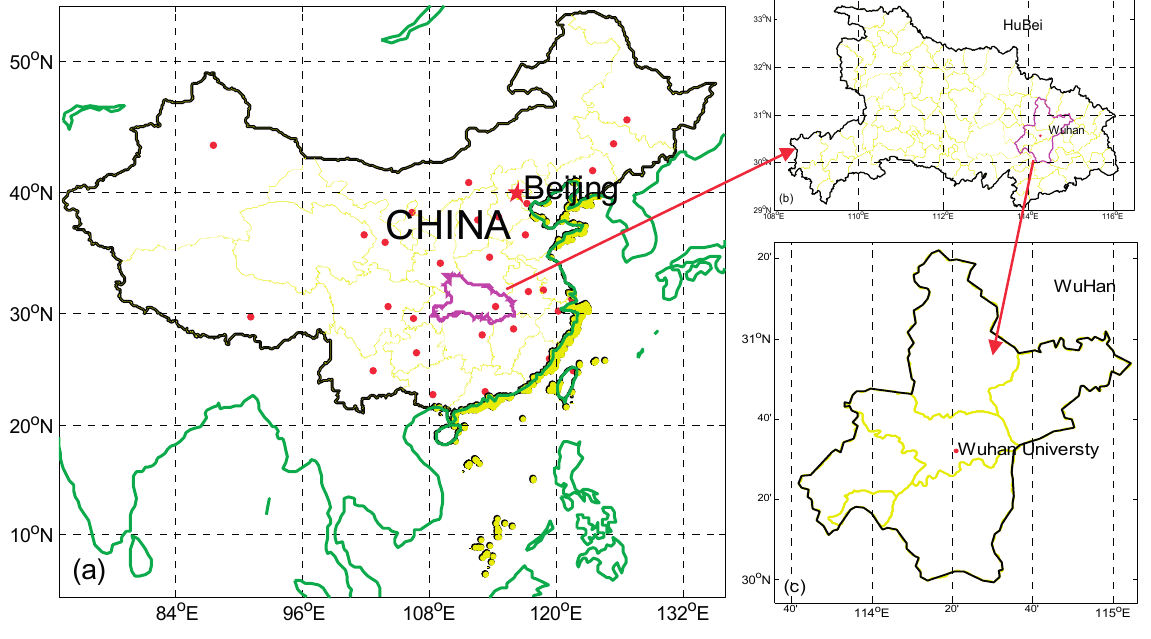
Figure 1. Location of Wuhan, China: ( a ) location of Hubei Province in China; ( b ) location of Wuhan in Hubei Province; and ( c ) sites of this study in Wuhan ( i.e. , Wuhan